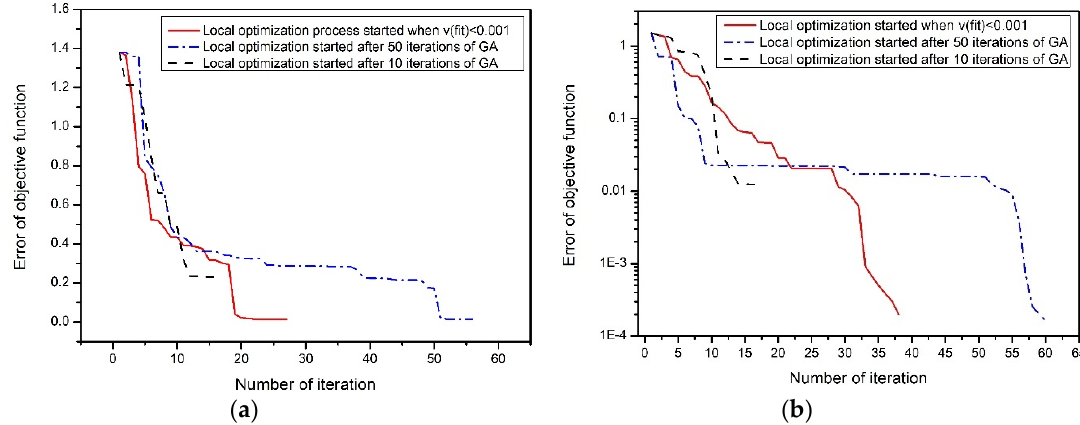
Figure 12. Error versus variance of fitness: ( a ) planar spiral inductor and ( b ) microstrip interdigital capacitor modeled by hybrid optimization method with three different starting points of local optimization process. Table 7. Error of the objective function by three different hybrid optimization methods.